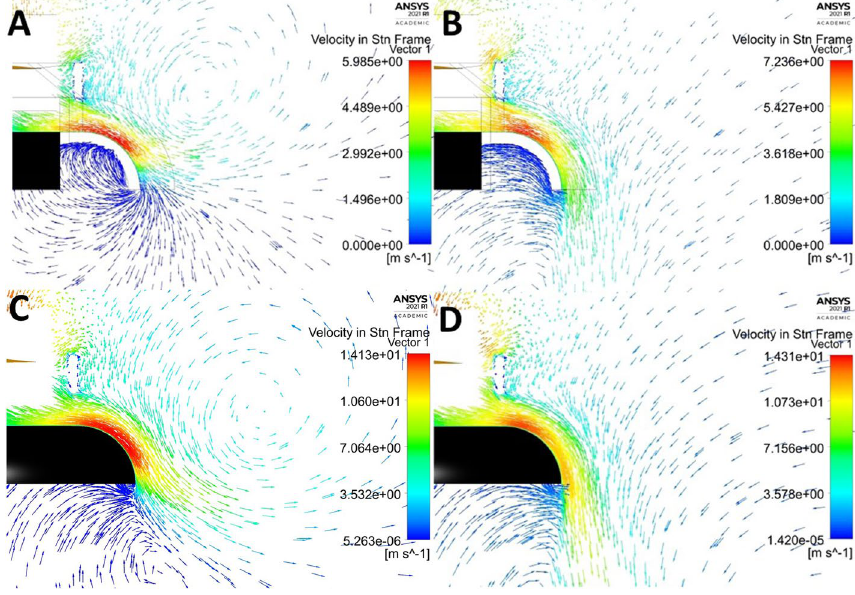
Fig. 10 A Novel design velocity vectors at 2100 RPM, B novel design velocity vectors at 4000 RP, C conventional design velocity vectors at 6000 RPM, and D conventional design velocity vectors at 8000